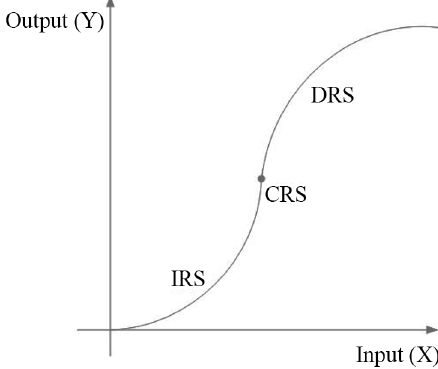
Fig. 4. Schematic diagram of returns to